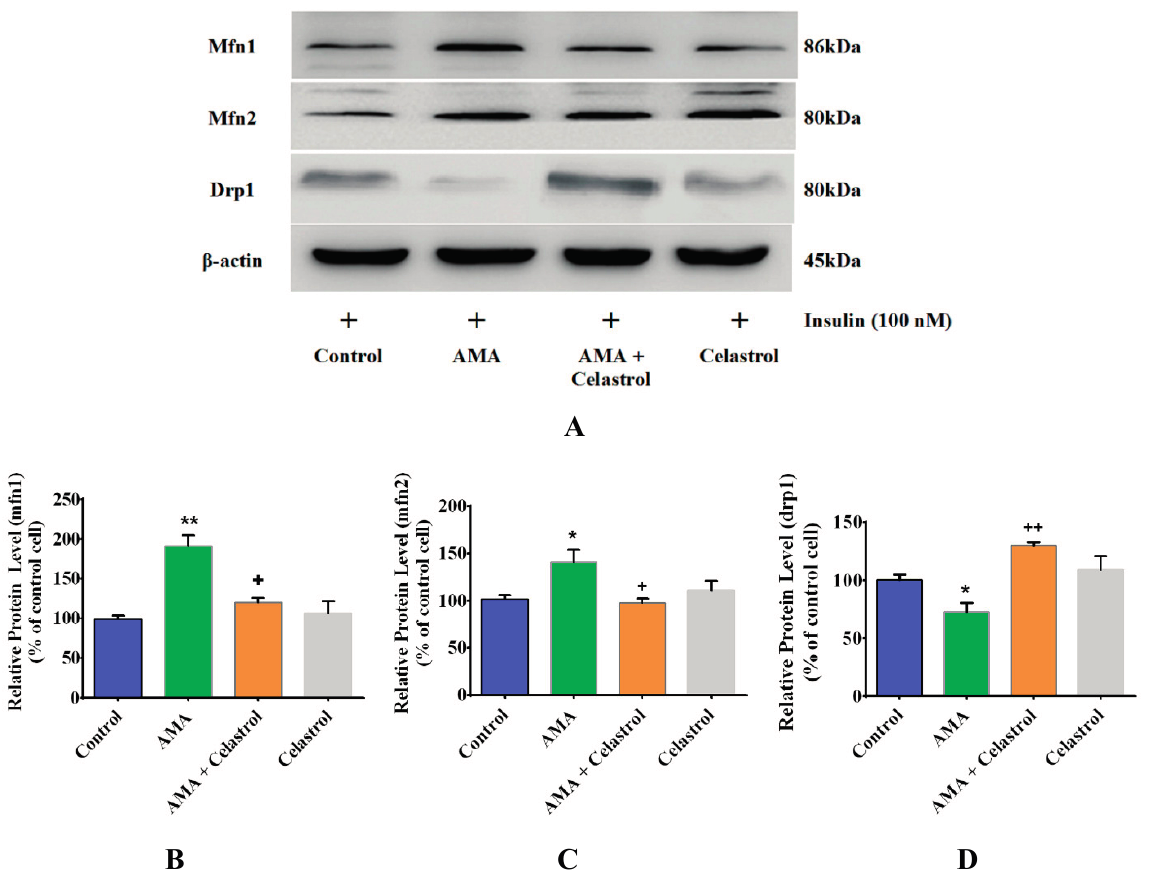
Figure 5. Effects of AMA and celastrol treatments on mitochondrial fusion and fission of human myotubes. Representative images of western blot analysis ( A ) on the relative expression of ( B ) mfn1, ( C ) mfn2 and ( D ) drp1 proteins were quantified with the corresponding antibodies using a densitometer. β -actin was used as loading control. Protein levels calculated by densitometry were normalized relative to β -actin signals. * p < 0.05 and ** p < 0.01 vs . untreated control; + p < 0.05 and ++ p < 0.01 vs . AMA-treated